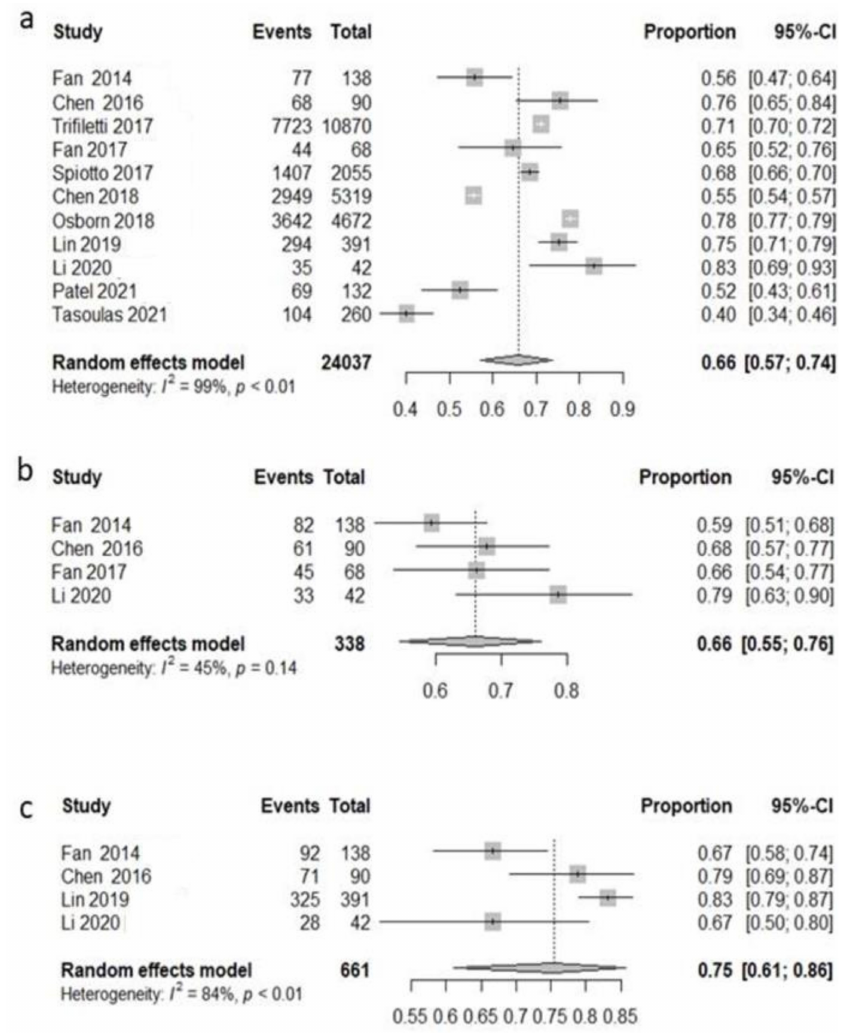
Figure 2. Forest plot, 3-year survival analysis, all patients included. Overall survival (OS) ( a ); disease-free survival (DFS) ( b ); local recurrence-free survival (LRFS) ( c ). Five studies [77–79,81,82] reported the 3-year disease-free survival. Globally, the pooled 3-year disease-free survival rate was 63.7% (95%CI: 54.7–71.9%) with moderate het- erogeneity (I 2 = 50.9%, p = 0.08) (Figure 2b). Only four studies [78,79,82,83] evaluated